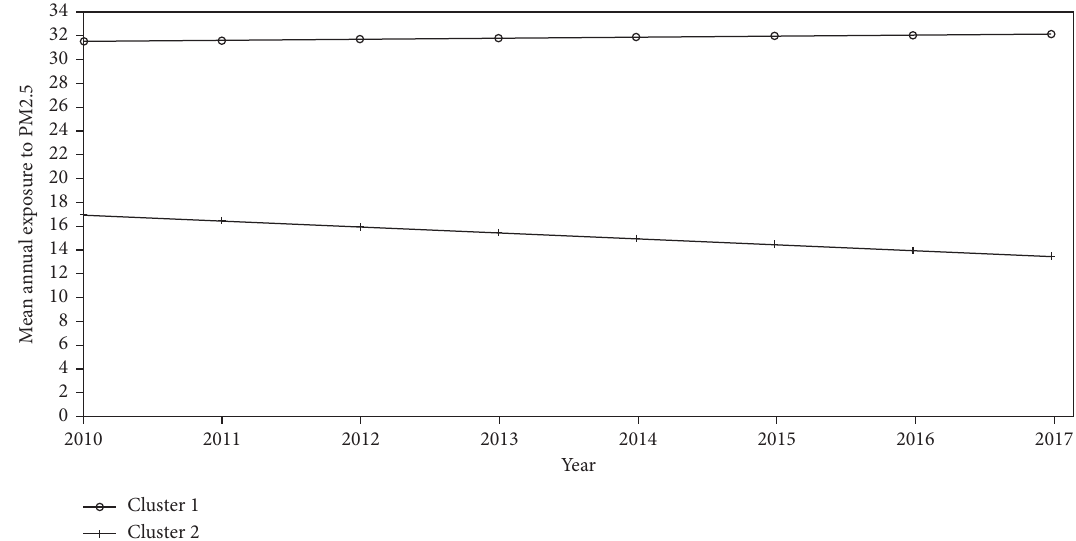
Figure 2: The linear trend of mean annual exposure to PM2.5 in the two identified